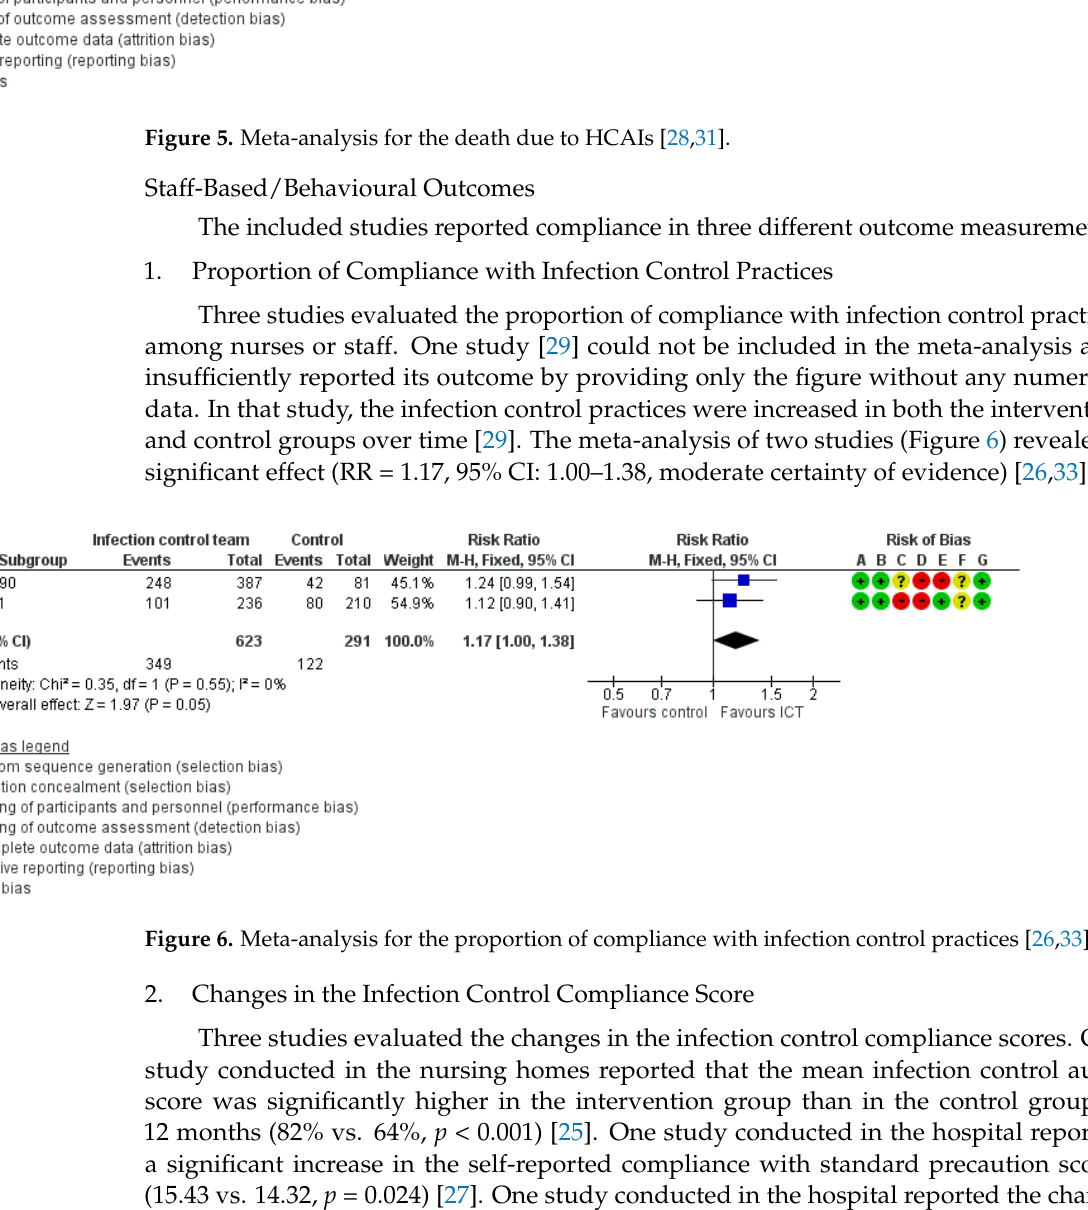
Figure 6. Meta-analysis for the proportion of compliance with infection control practices [26,33].